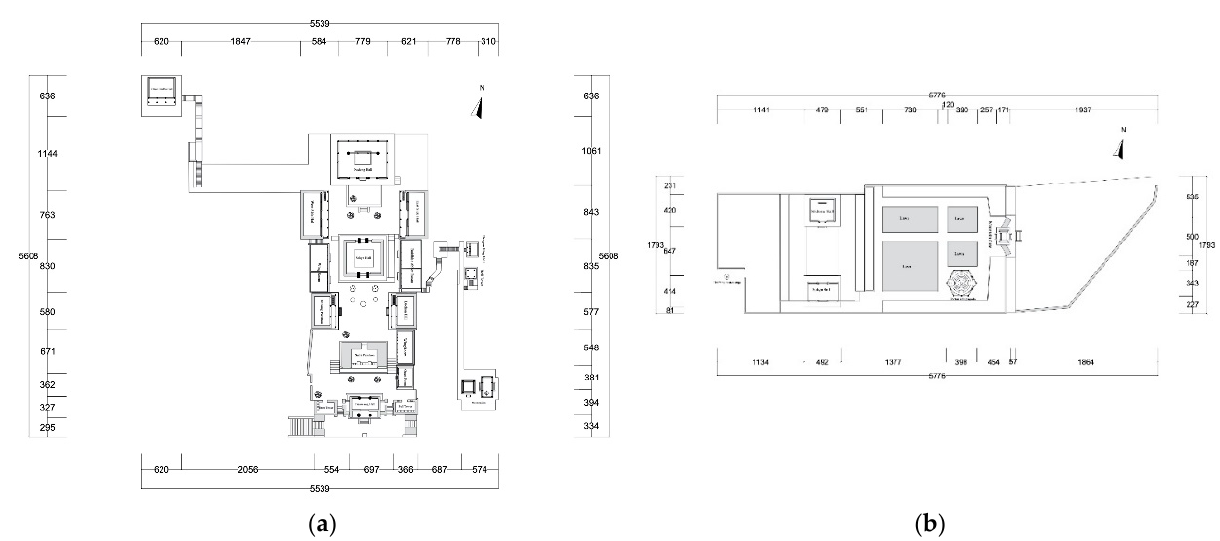
Figure 7. Spatial layout of Qinglian Temple: ( a ) the Upper Temple and ( b ) the Lower Temple.